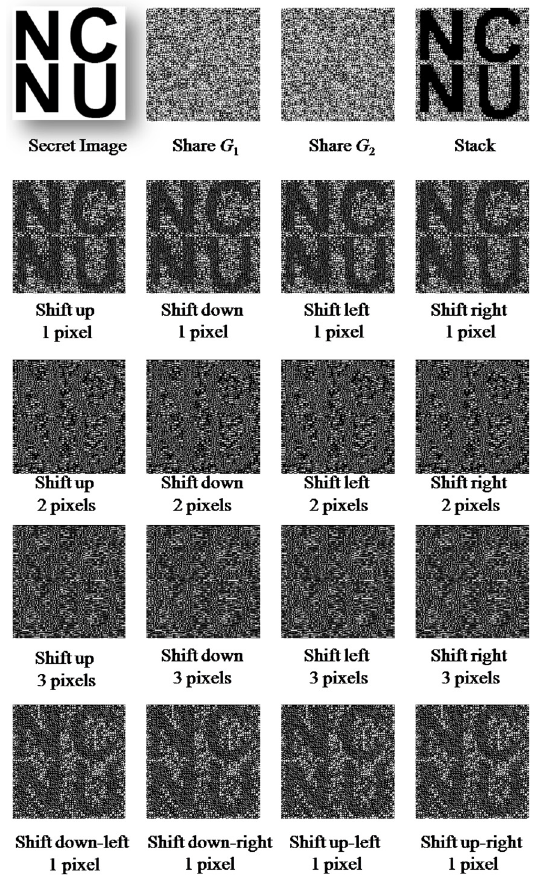
Figure 7. The experimental results for n = 6.